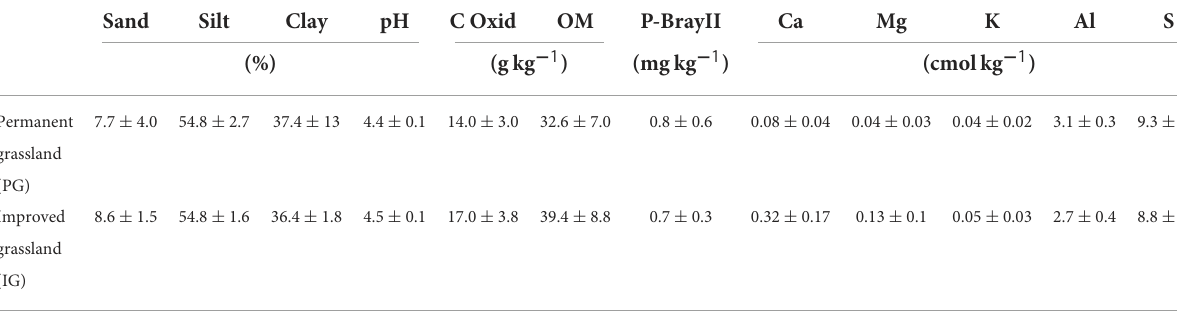
TABLE 1 Grassland conditions of the two pasture-based beef cattle production in the Orinoquia region of Colombia. Grassland conditions Permanent grassland (PG) Improved grassland (IG) Pasture species Native savanna Urochloa humidicola cv. Humidicola (CIAT 679) Grazing system For centuries extensive management with annual Rotational grazing. burning of pastures. Free of burning and cattle Radial distribution of paddocks with drinking troughs and cattle salting for animals’ grazing in the last 7 years. welfare. Pasture height at the entrance of animals to paddocks: ∼ 30cm. Pasture height at exit of animals to paddocks: ∼ 15cm. Stocking rate While grazed: 0.06AU ha − 1 (1AU in 17 ha) 1AU ha − 1 None Dolomitic lime, phosphate rock and gypsum in 2017 to decrease soil acidity and to improve nutrient supply AU,animalunit,450kgliveweight. TABLE 2 Soil physical and chemical characteristics (0–20cm) of two grassland systems at Hacienda San Jose (HSJ), Colombia. Sand Silt Clay pH C Oxid OM